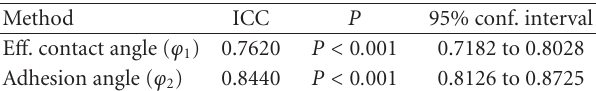
Table 1: Intraclass correlation coe ffi cient (ICC) as a measure of interobserver reliability. The P values and the 95% confidence intervals for both types of the measured angles are also